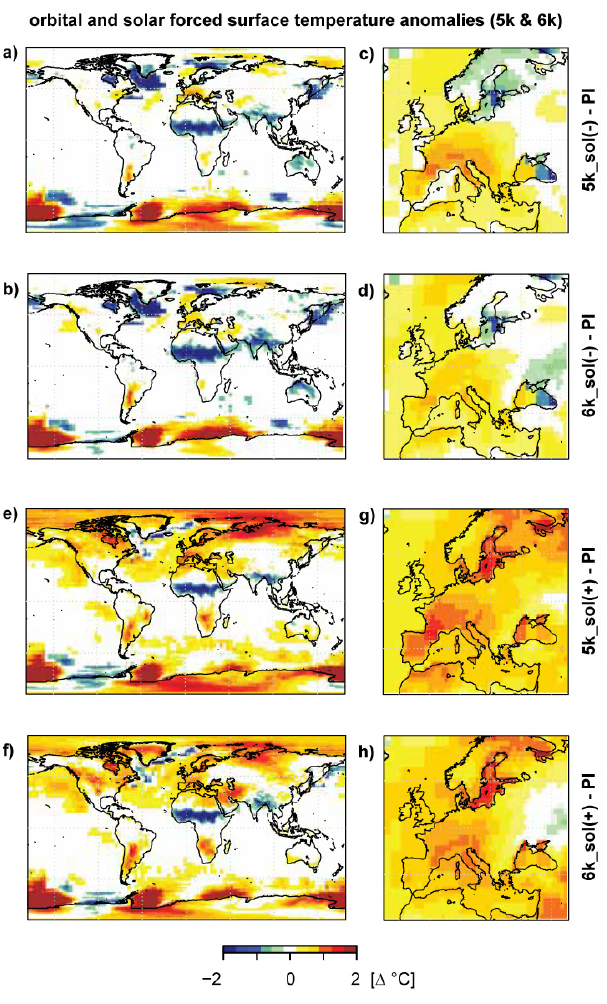
Fig. 9. Same as Fig. 8 but for δ 18 O in precipitation